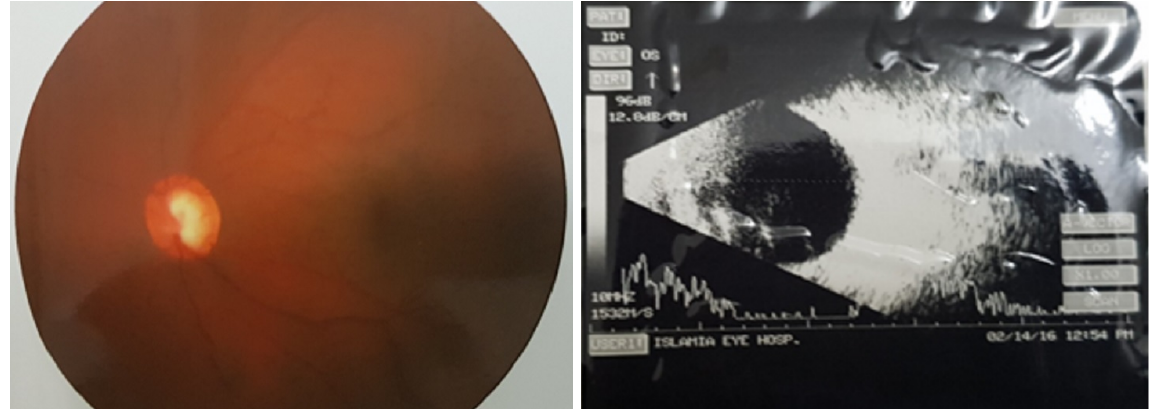
Figure 1: Fundus photograph of the left eye showing a vertical cup disc ratio of 0.7 and B-scan ultrasonography showing no